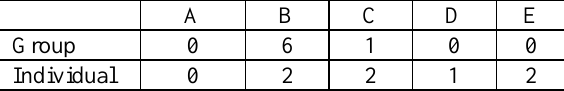
Table 6: Categorising learners’ results for problem 2